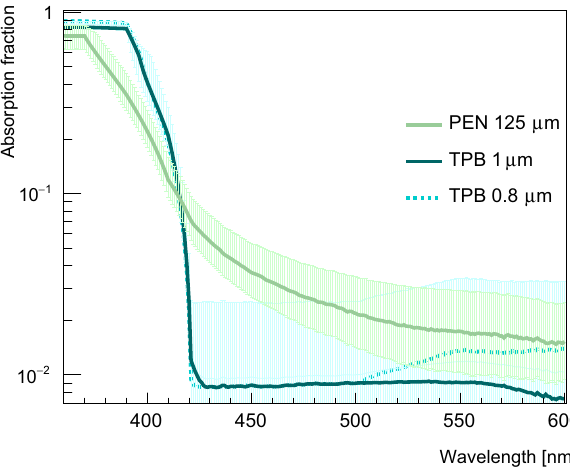
Fig. 7 Absorption fraction of the PEN and TPB films. The line from TPB 0 . 8 µ m is only clearly visible above 500nm (the lines almost over- lay below this value). The uncertainty bands are discussed in the